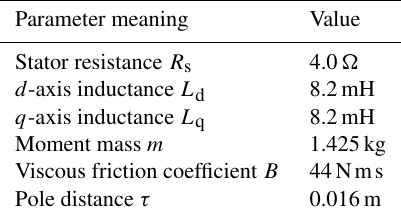
Table 1. Main parameters of a straight line. Parameter meaning